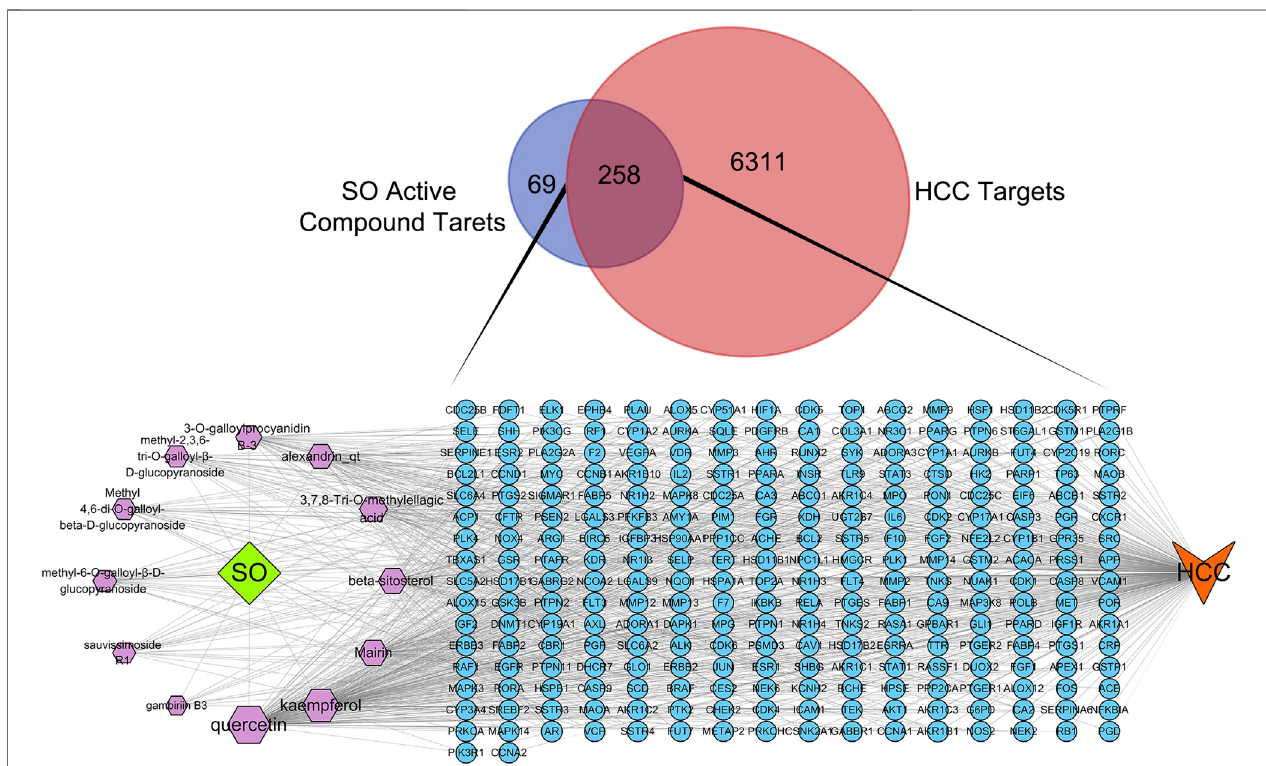
FIGURE3| TheVenndiagramofHCCtargetsandSOactivecompoundtargetsandC-D-TnetworkofSO.Thebluecirclestandsforgene,purplehexagonstands for compounds of SO. The green diamond stands for SO, and orange V shape stands for HCC.